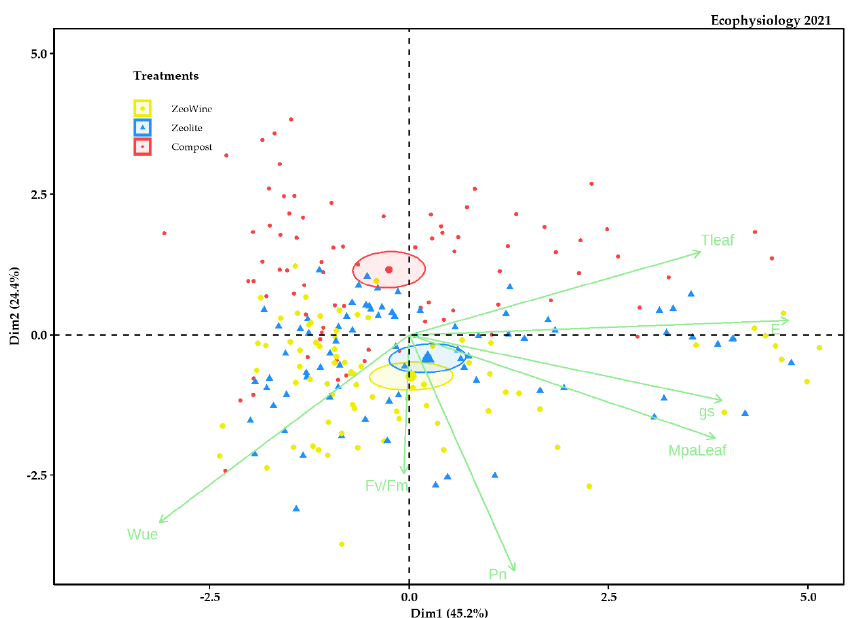
Figure 9. PCA ecophysiology 2021 season. PCA of the following variables (27 May, 9 June, 28 June, 12 July, 29 July, 18 August, 31 August, and 14 September): stem midday water potential, net photosynthesis, transpiration, leaf temperature, stomatal conductance, the fluorescence of chlorophyll, and water use efficiency. The compost treatment was to the upper part of the distribution and positively re- lated to the transpiration and leaf temperature and negatively related to eWUE and Fv/Fm (Dim1 45.2%). Instead, PC 2 (Dim2) explained 24.4% of the data variability.